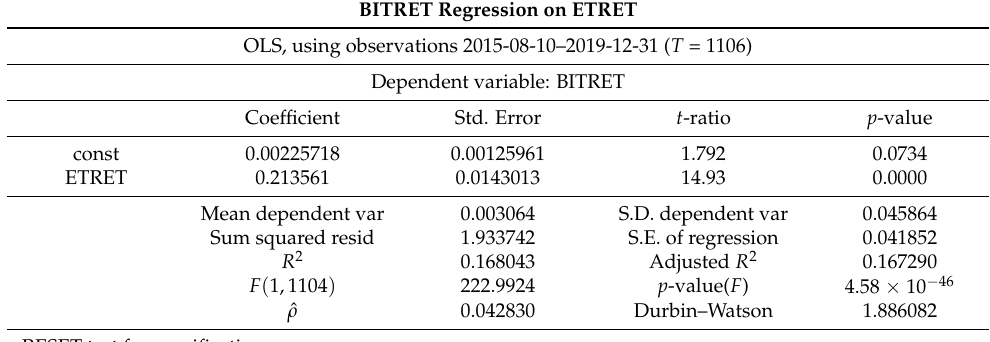
Table 3. Return Regressions